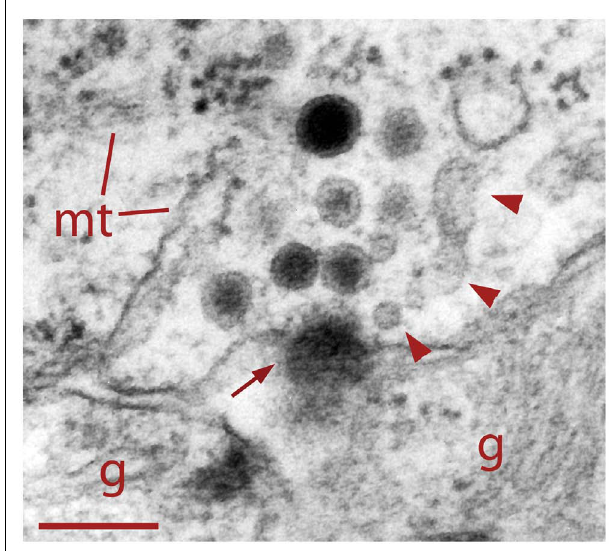
FIGURE 4 | Dense core vesicle fusion after electrical stimulation (arrow). To the right of the fusing vesicle are small clear vesicles and cisternae (arrowheads) atypical of somatic clusters before electrical stimulation.This suggests vesicle formation as part of the endocytic pathway. Glial cell fingers (g) can be seen outside the Retzius cell. Scale bar =